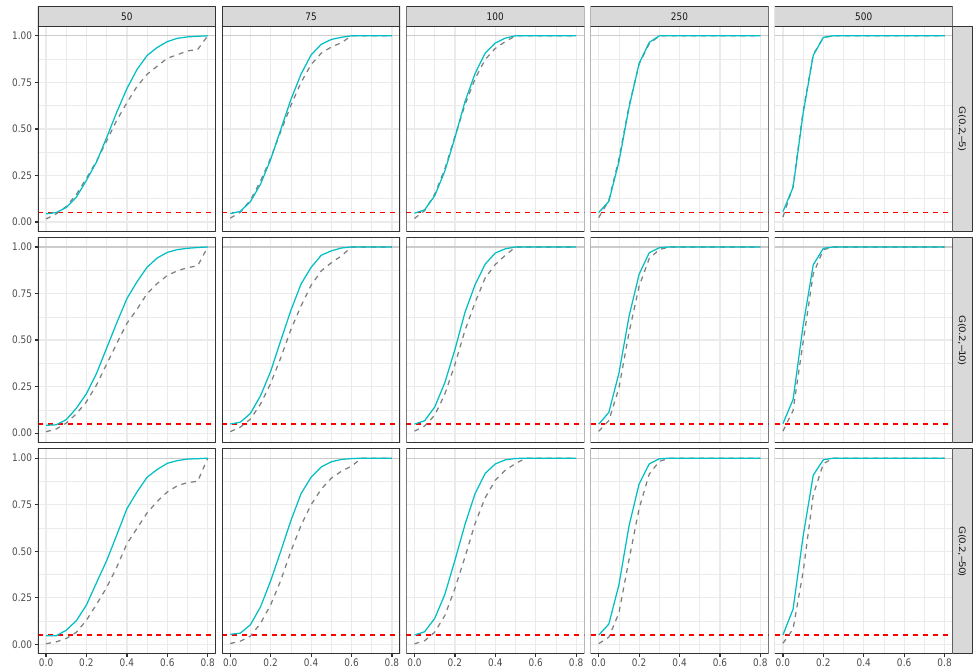
Figure A2. Empirical power of the bootstrap-based score test under Good arrivals (lightblue line) . The black dashed line is the empirical power of asymptotic test while the red dashed line represents the nominal level of